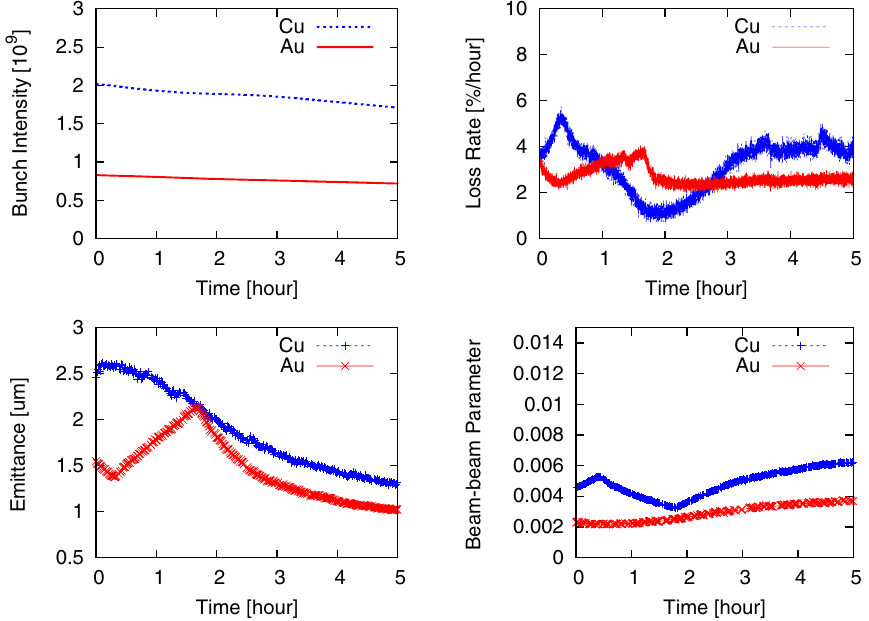
FIG. 16. Beam parameters for the store during our first attempt to slow down Au cooling rate. Top left: bunch intensities. Top right: beam loss rates. Bottom left: normalized transverse emittances. Bottom right: total beam-beam